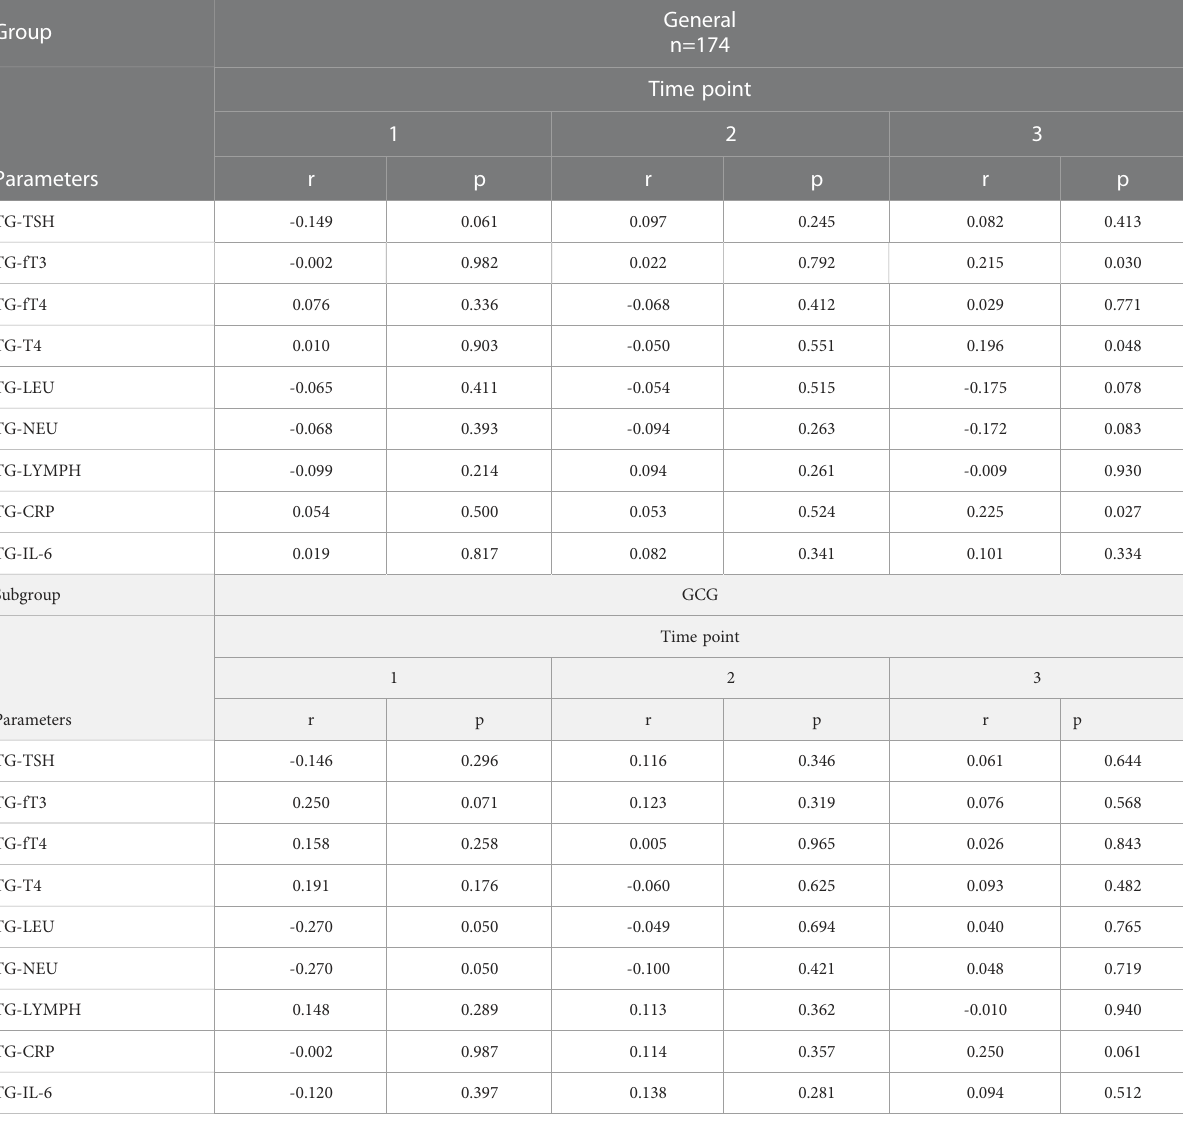
TABLE 4 Relationship between TG concentration and various in fl ammatory and hormonal parameters.